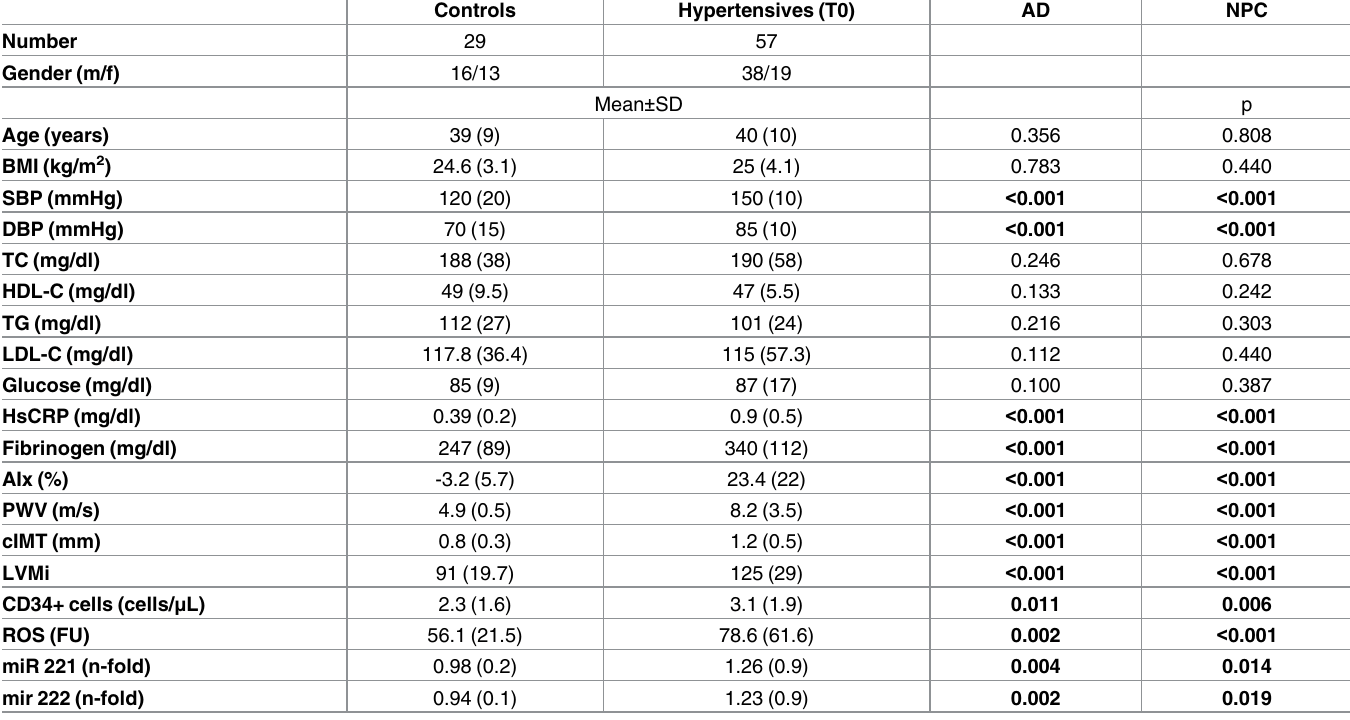
Table 1. Characteristics of hypertensive patients at baseline (T0) and control subjects. Controls Hypertensives (T0) AD